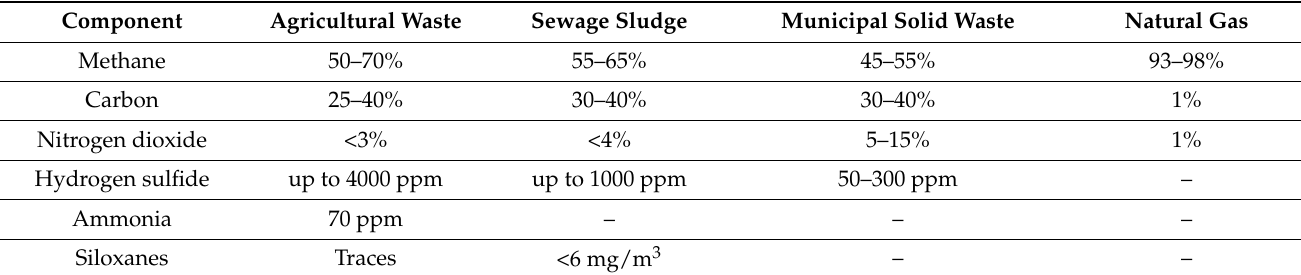
Table 1. Composition of